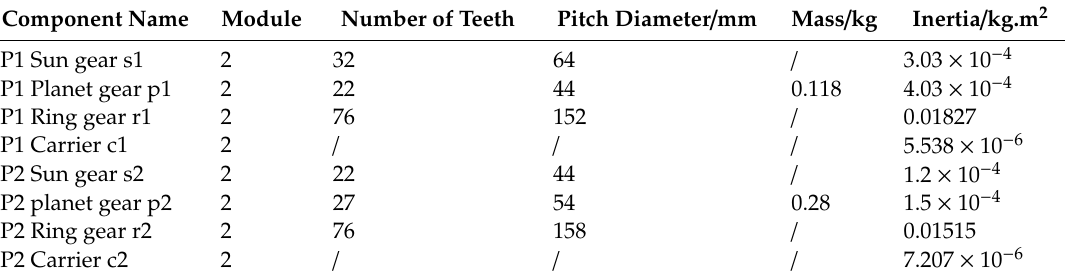
Figure 1. Schematic diagram of the planetary two-speed transmission. 1-driving motor; 2-sun gear in planetary system 1(S1); 3-carrier in planetary system 1 (C1); 4-brake 1(B1); 5-ring gear in planetary system 1 (R1); 6-worm shaft; 7-worm gear; 8-ring gear in planetary system 2 (R2); 9-carrier in planetary system 2 (C2); 10-sun gear in planetary system 2(S2); 11-brake 2(B2). Table 1. Parameters of the planetary system.